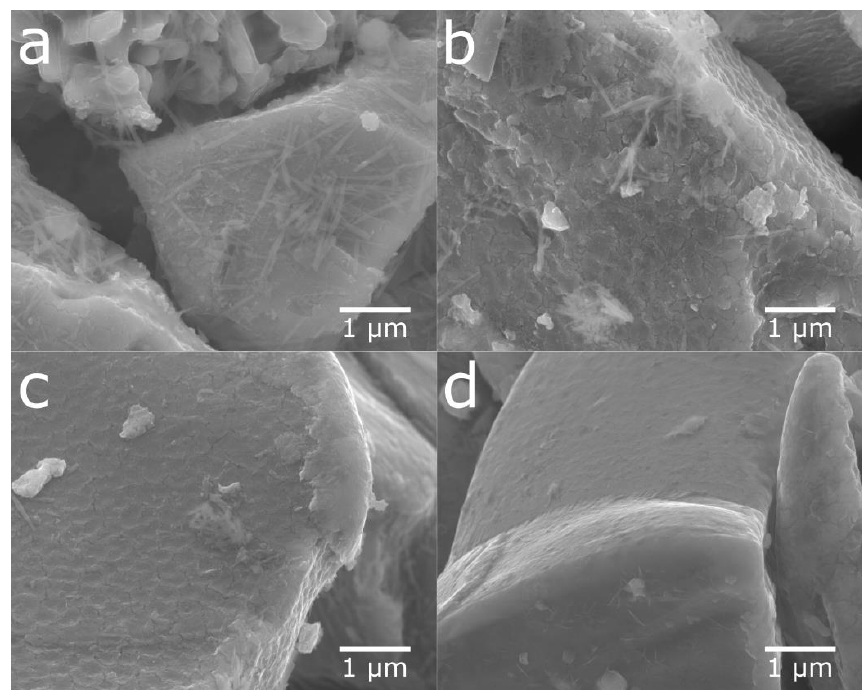
Figure 1. SEM secondary electron images at 20,000 times magnification. Sonotrode-sonicated samples of cycled material at ( a ) t = 0, ( b ) t = 5 min, ( c ) t = 30 min, and ( d ) t = 2 h. The amount of needle-like rare-earth crystals laying parallel to the metal surface in ( a ) is seen to decrease when going from ( a ) to ( d ).